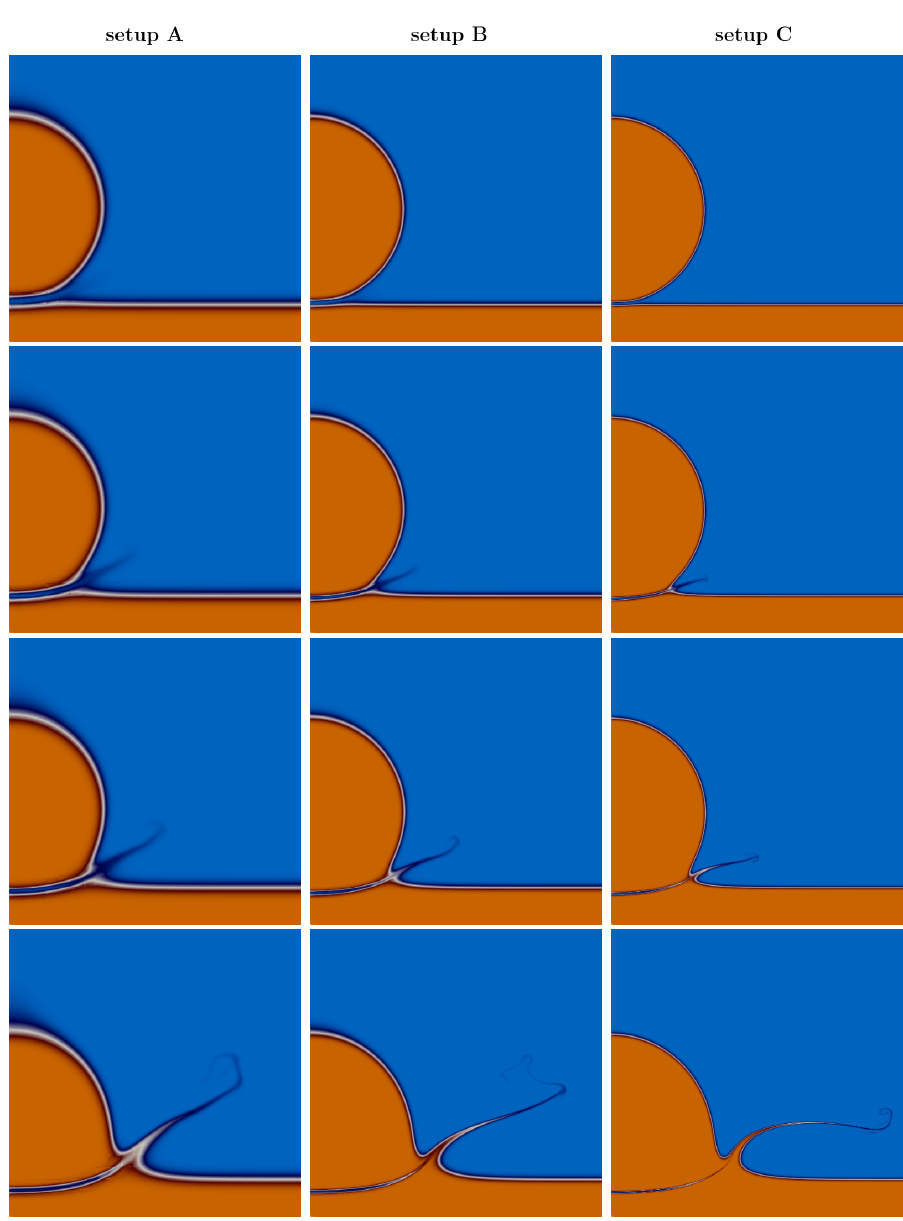
Figure 8. Impinging droplet—density field for setup A ( left column ), B ( middle column ) and C ( right column ) at non-dimensional times 0.45, 0.50, 0.55, and 0.70 from top to bottom. Color scale denotes water with orange and air with blue (see Figure 7 for